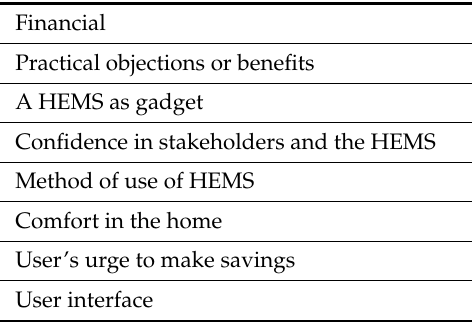
Table 1. Categorisation of statements in Q-set.